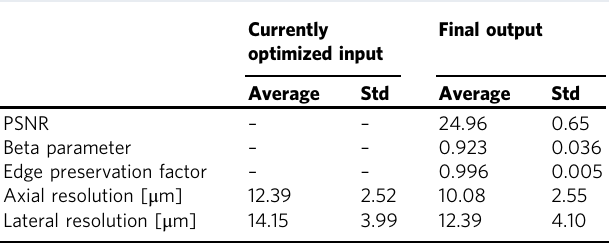
Table 2 Quantitative performance evaluation results of deep learning-based OCT image enhancement framework for reducing noise (PSNR), preserving morphological features (Beta parameter and edge preservation factor), and enhancing spatial resolution (axial resolution and lateral